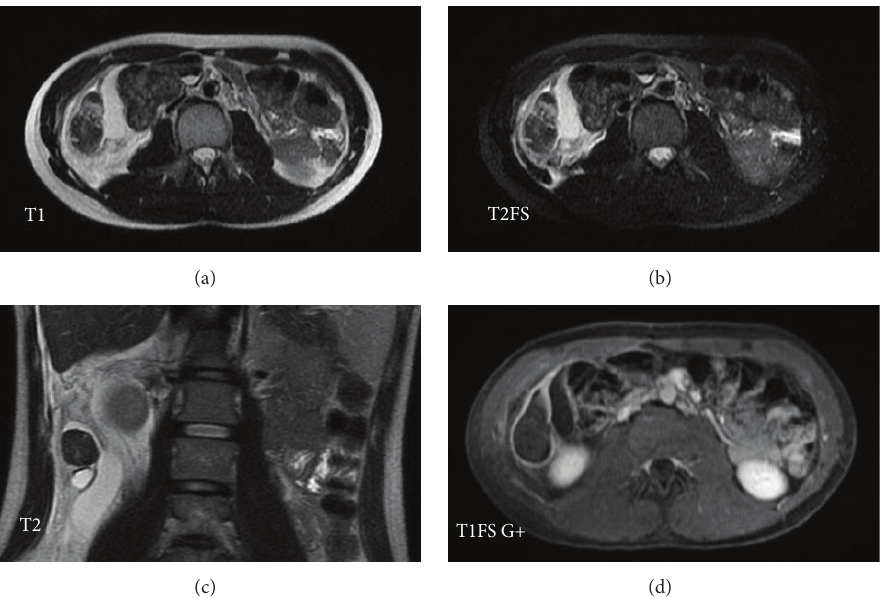
Figure 3: Axial MRI images (a) and (b) demonstrate a mostly hypointense structure on T1 and T2FS sequences in the right upper quadrant with surrounding fluid and edema. On the coronal T2 image (c), a cystic component is seen inferior to this mostly T2 hypointense mass. Axial post contrast image (d) shows peripheral enhancement.